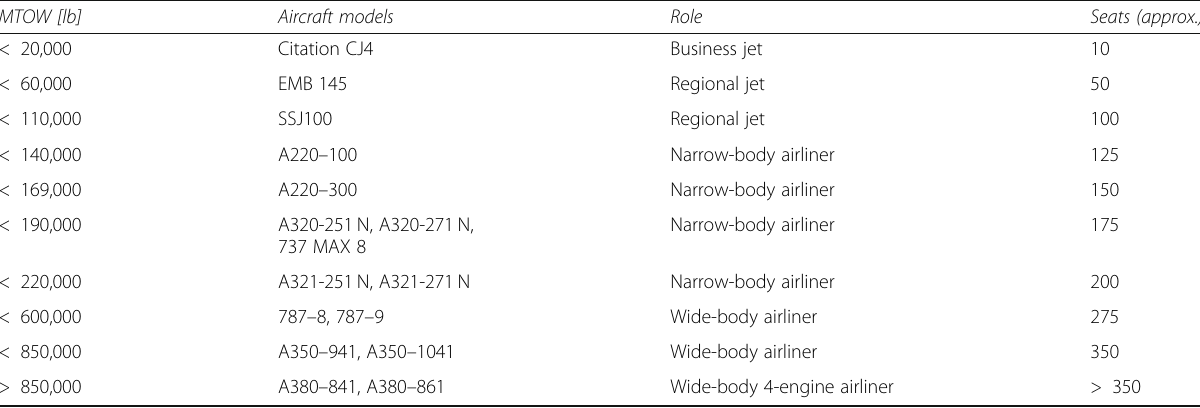
Table 1 Supply pool of best-in-class ANP-available aircraft models for the new aircraft fleet in 2025 MTOW [lb] Aircraft